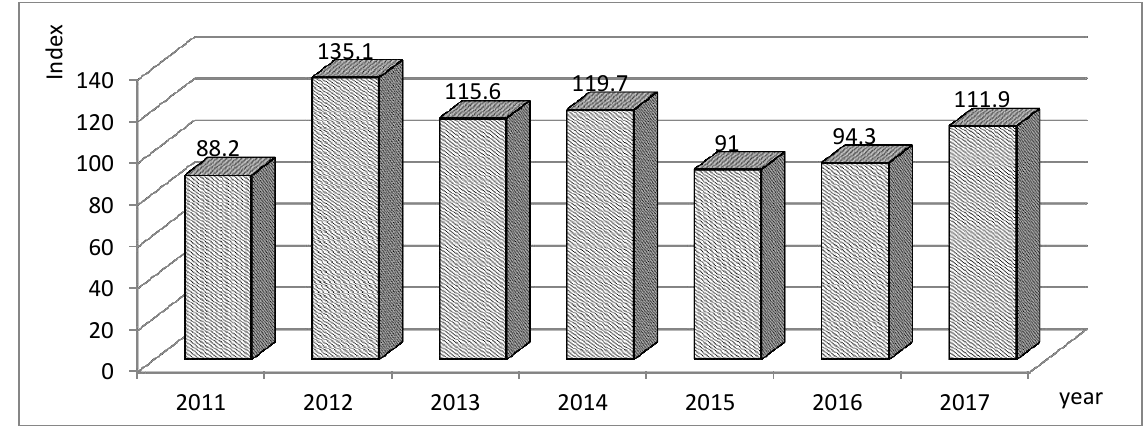
Fig. 3. Dynamics of change of capital investment index in the production of basic pharmaceutical products and pharmaceuticals of Ukraine in the period of 2011–2017 gg. (calculated for